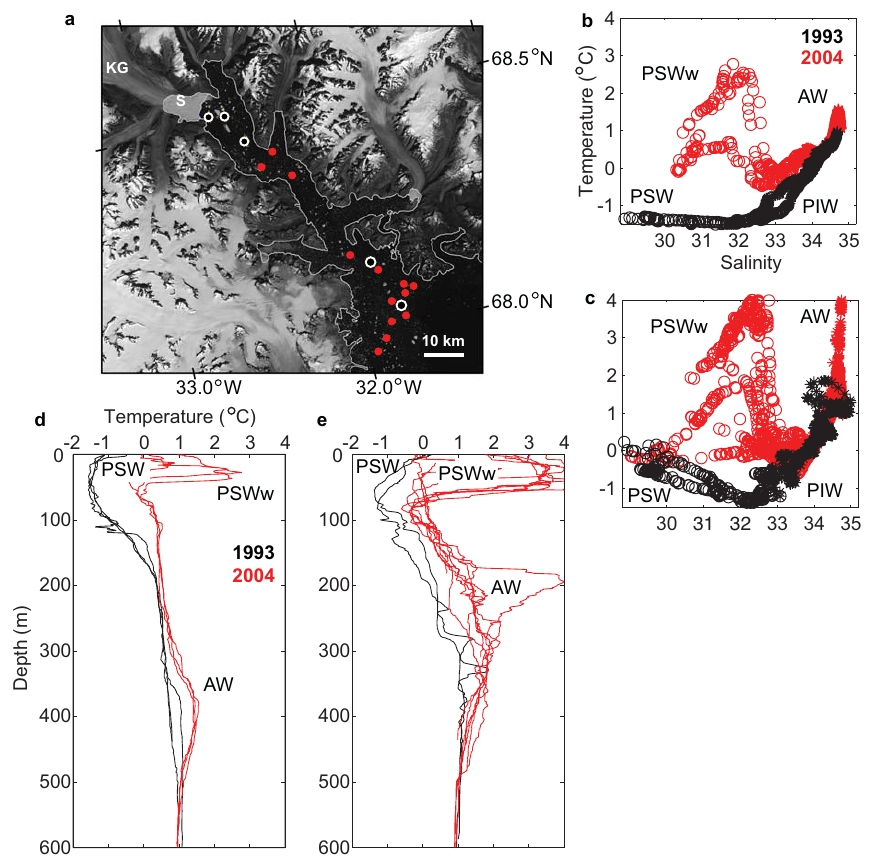
Fig. 3. (a) Landsat image showing KG and KFj on 16 August 2002. White circles show locations of CTD casts in 1993 and red dots show corresponding stations in 2004. (b) Potential temperature and salinity from CTD data acquired in the upper central fjord (68.4 ◦ N, 32.2 ◦ W) in 1993 (black) and 2004 (red). Data from 0–100m are marked open circles and deeper measurements are shown with asterisk. (c) Same as (b) but for data acquired at fjord mouth (68.1 ◦ N, 31.9 ◦ W). (d) Potential temperature from CTD casts in upper fjord in 1993 (black) and 2004 (red). (e) Same as (d) , but for CTD casts near fjord